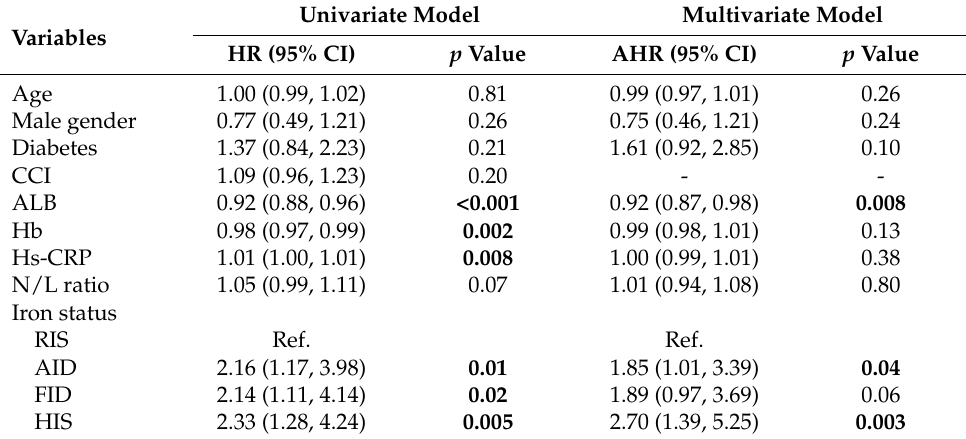
Table 3. Univariate and multivariate cox regression analysis with time-dependent covariates for longitudinal iron status and the treatment failure of